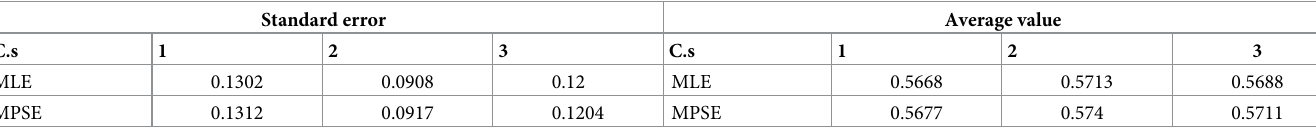
Table 15. Standard error and average value for each estimate after bootstrapping for example